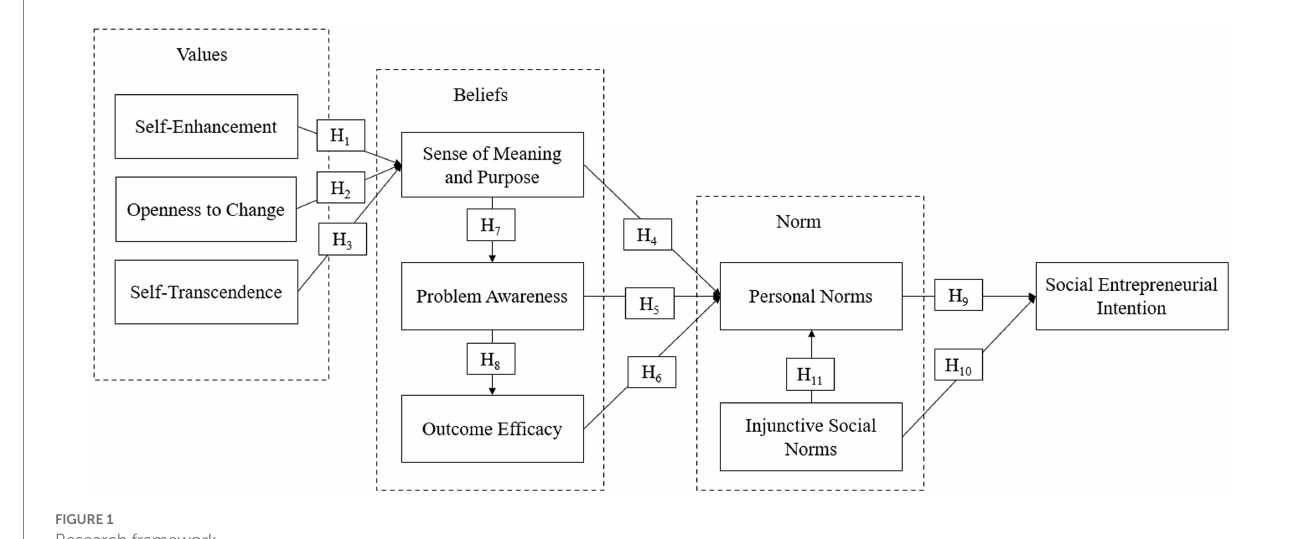
FIGURE 1 Research